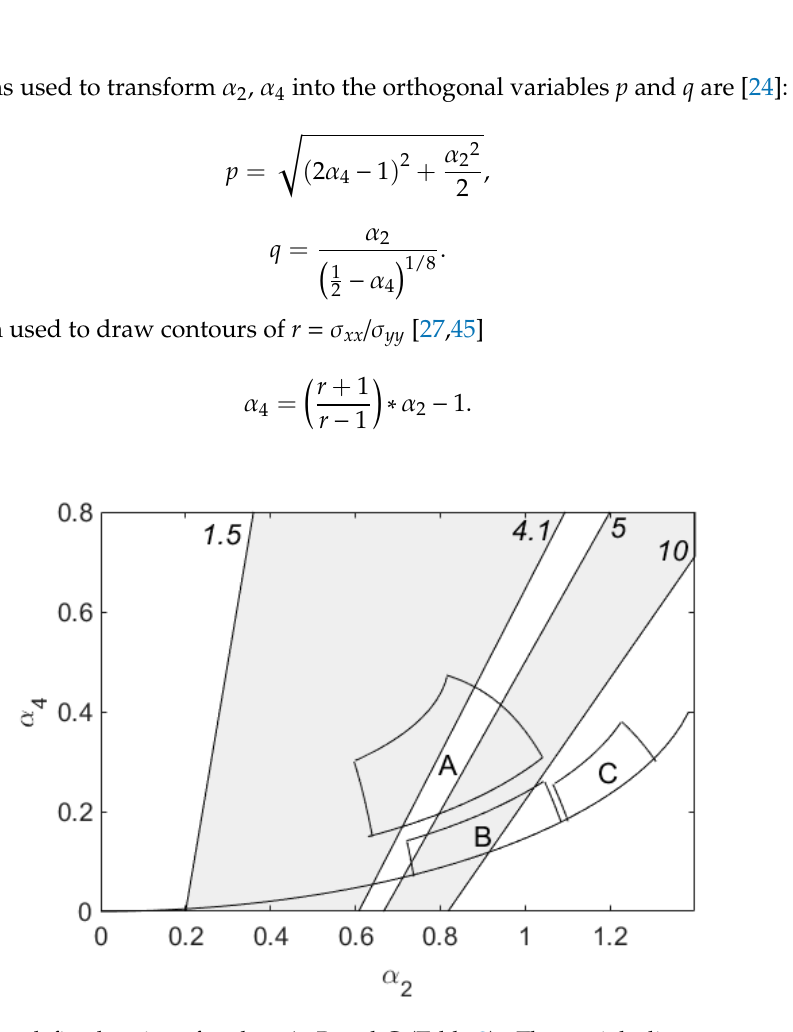
Figure A1. The defined regions for class A, B and C (Table 2). The straight lines are contours of r = σ xx / σ yy with values 1.5, 4.1, 5 and 10. The grey areas are the regions defined by References [13,14] to select ladybirds and hoverflies (Table A1).